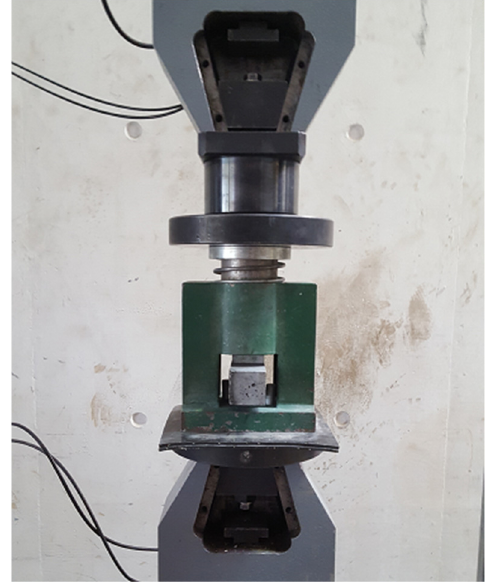
Figure 5. Compressive strength test set-up.